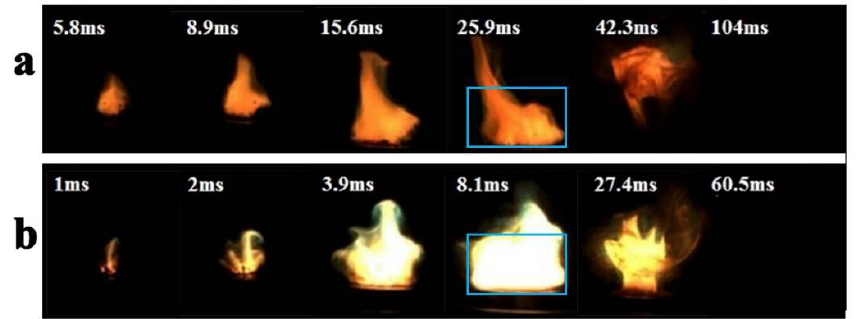
Figure 7. Combustion process of B(11%)/NC/CuO thermite in the air: ( a ) electrosprayed; ( b ) ball-milled.